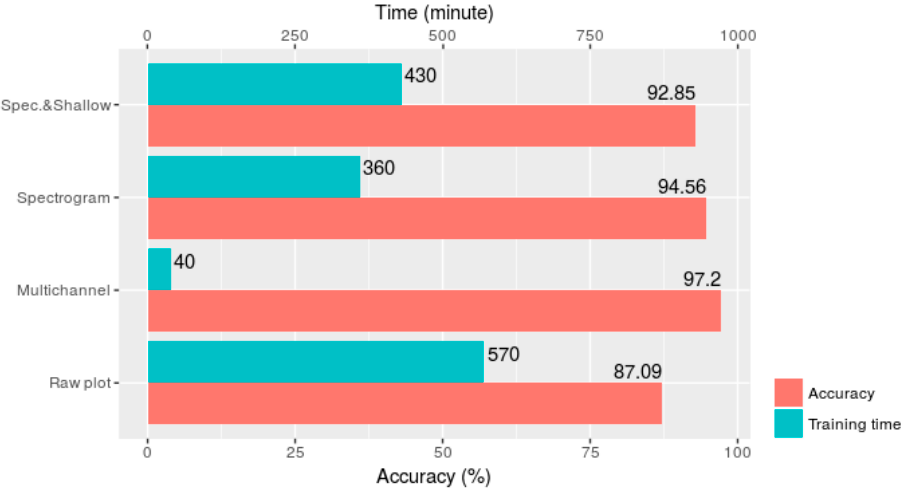
Figure 6. Classification accuracy and training time of the four data transformation methods.